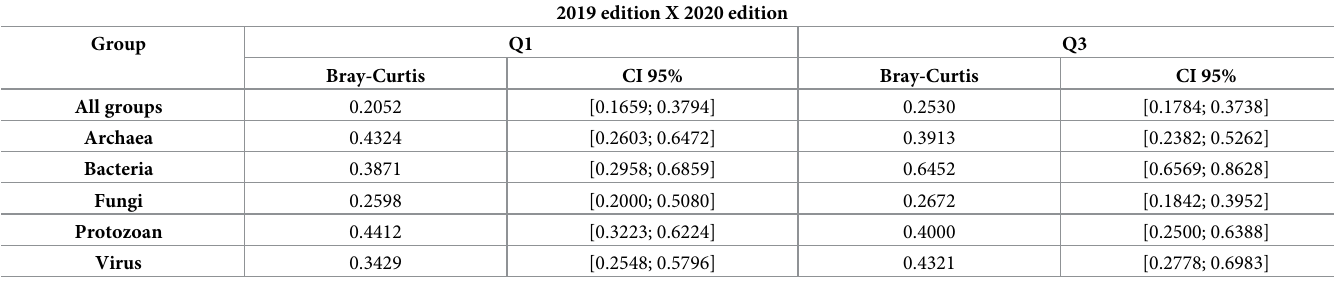
Table 3. Bray-Curtis dissimilarity of the survey responses between the 2019 and 2020